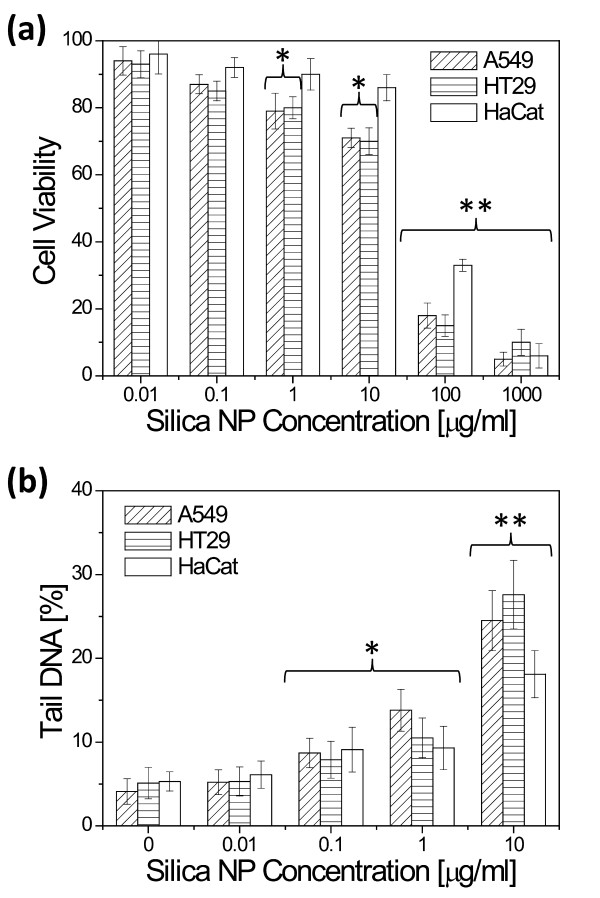
(a) Viability of A549, HaCat and HT29 cells incubated with silica NPs for 24 hrs as determined by the MTT assay. * and ** indicate that the viability is significantly lower than the control with p < 0.05 and p < 0.01, respectively. (b) DNA strand breaks induced by silica NP incubation for 24 hrs as determined by the Comet assay. * and ** indicate that the DNA tail is significantly longer than the control with p < 0.05 and p < 0.01, respectively.